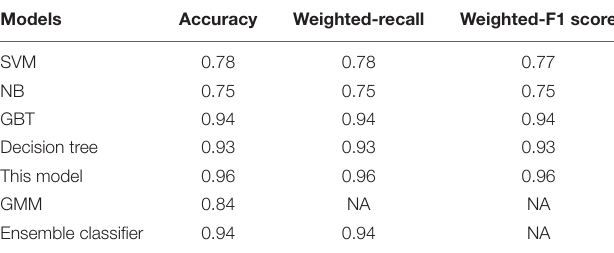
TABLE 3 | Model performance